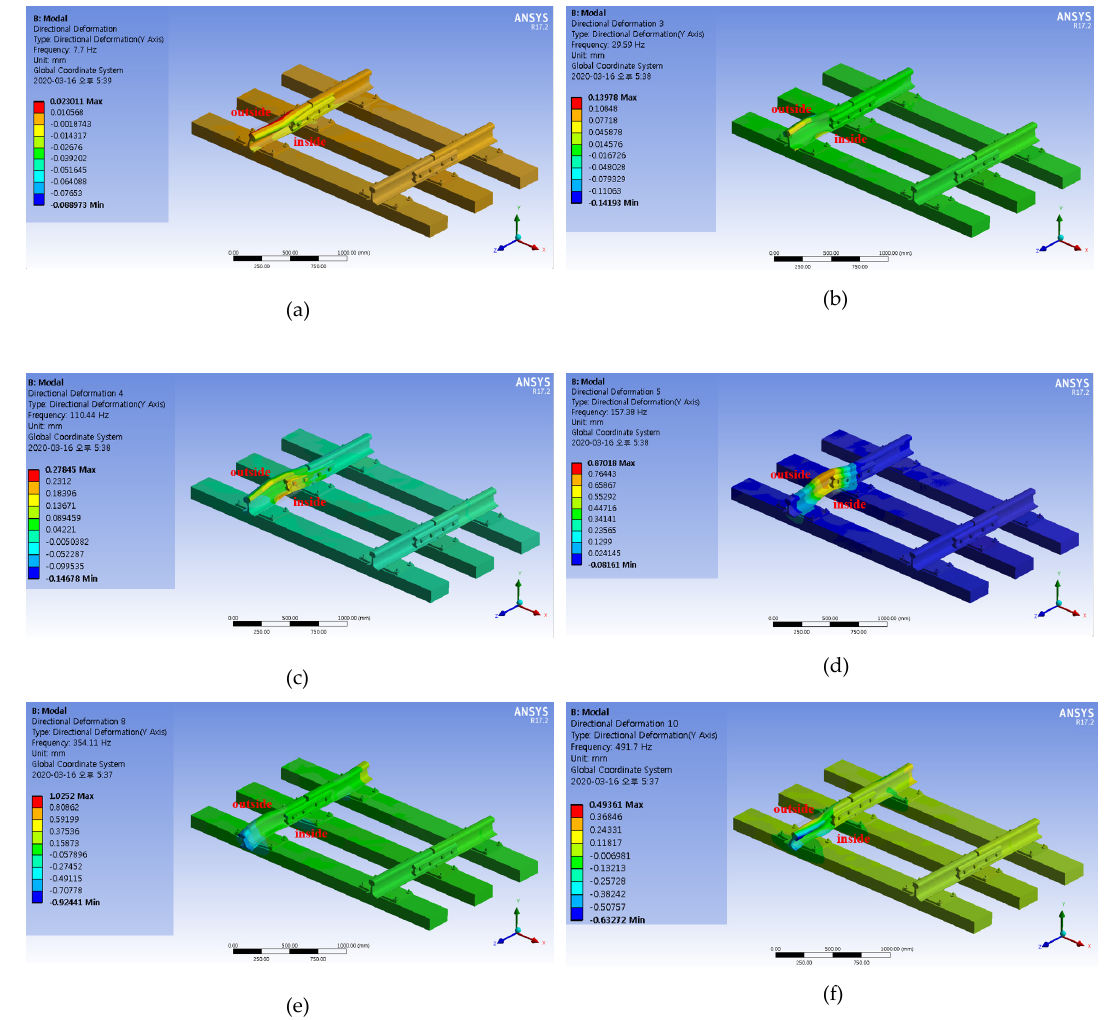
Figure 8. Examples of mode shapes of the jointed rail. ( a ) Mode 1; ( b ) mode 3; ( c ) mode 4; ( d ) mode 5; ( e ) mode 8; and ( f ) mode 10. ( e ) mode 8; and ( f ) mode 10. Table 5. Frequencies of the ten modes of the jointed rail.